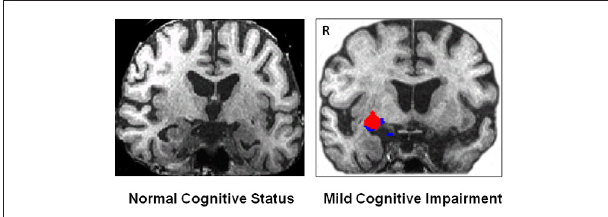
FIGURE 2 | Pilot data from Broster et al. (2012) corroboratingthe findings of Rosenbaum et al. (2010). We observe significant right amygdala activation during a working memory task in an older patient with mild cognitive impairment (right, white background), but not in an older control participant (left, black background). The red blob shows activation from the Z map of all objects ( p < 0 .